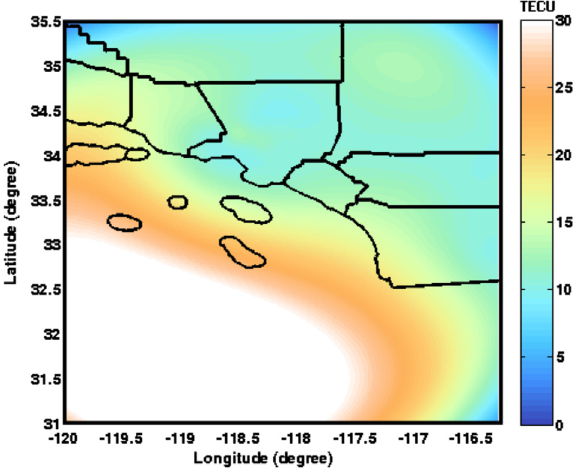
Figure 5. 3-D VTEC model of GPS and satellite altimetry combined, for August 25, 2012, 70:45:00 (UT) for j = 4, RMSE = 0.08